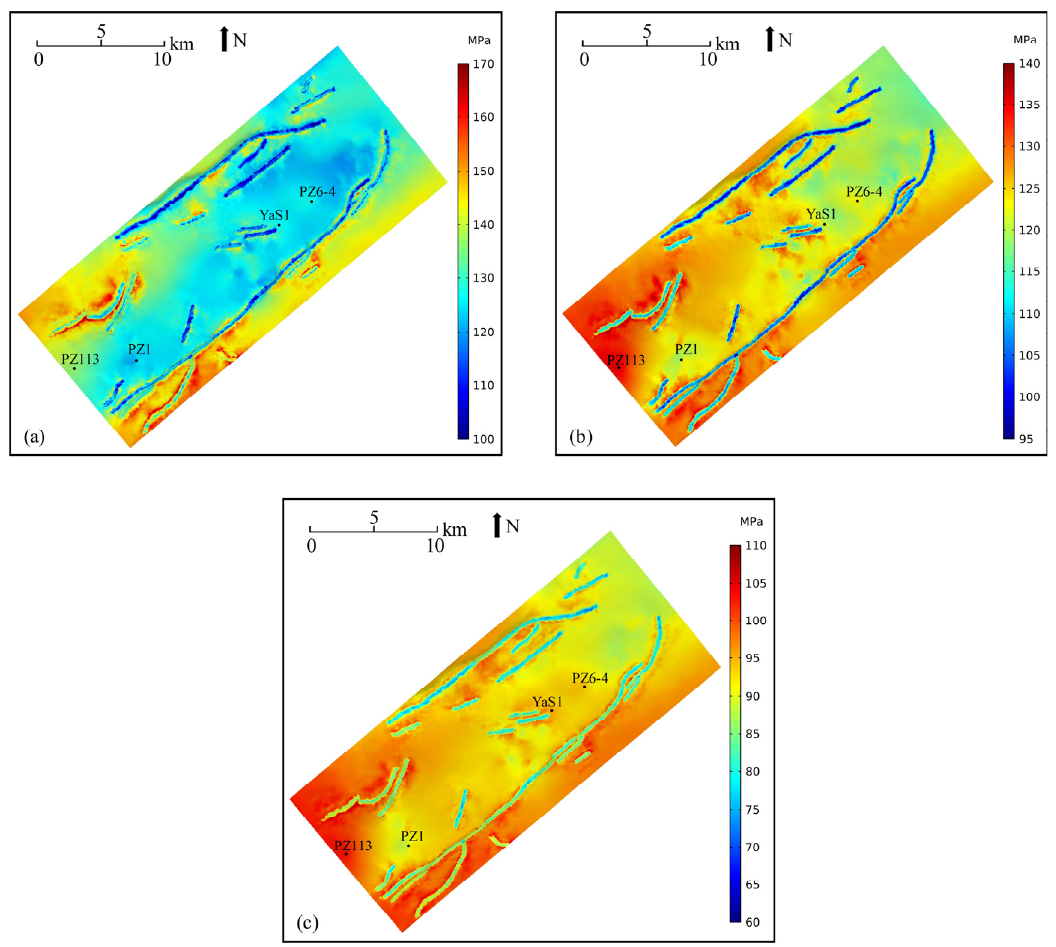
Figure 9. Plots showing the paleotectonic stress fields for the T 2 l 4 Formation in the Pengzhou area during the Himalayan period. ( a ) Maximum principal stress, ( b ) intermediate principal stress, and ( c ) minimum principal stress.